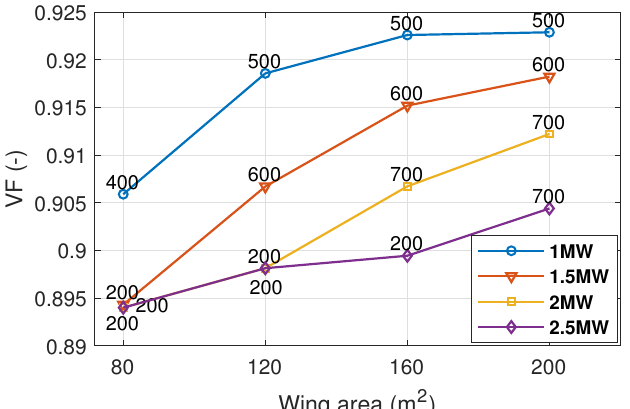
Figure 13. Maximum value factor trend for the onshore business case. The labels at the data points quantify the F t,max in